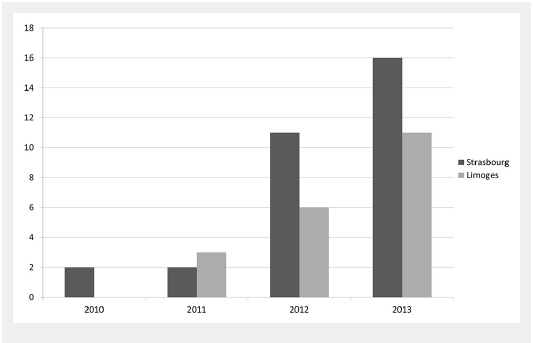
Number of Moraxella osloensis samples over time in the teaching hospitals of Limoges and